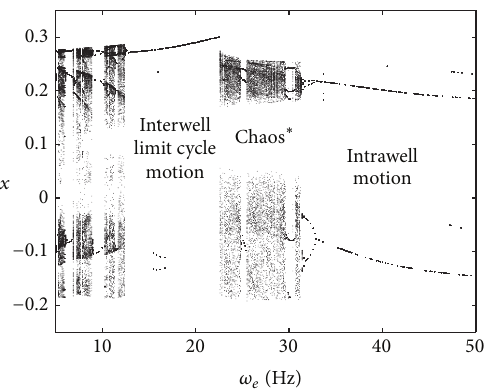
Figure 4: Bifurcation diagram as the excitation frequency 𝜔 𝑒 is increasedfor 𝑍 𝑒 = 2.5𝑔 ,where“ ∗ ”indicateschaoticregion,includes several periodic windows.